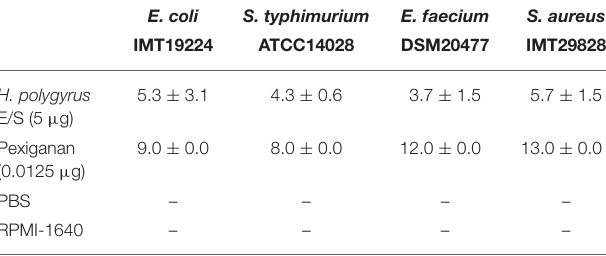
TABLE 1 | Antimicrobial activity* of excretory/secretory products from adult Heligmosomoides polygyrus nematodes in the radial diffusion assay. E.